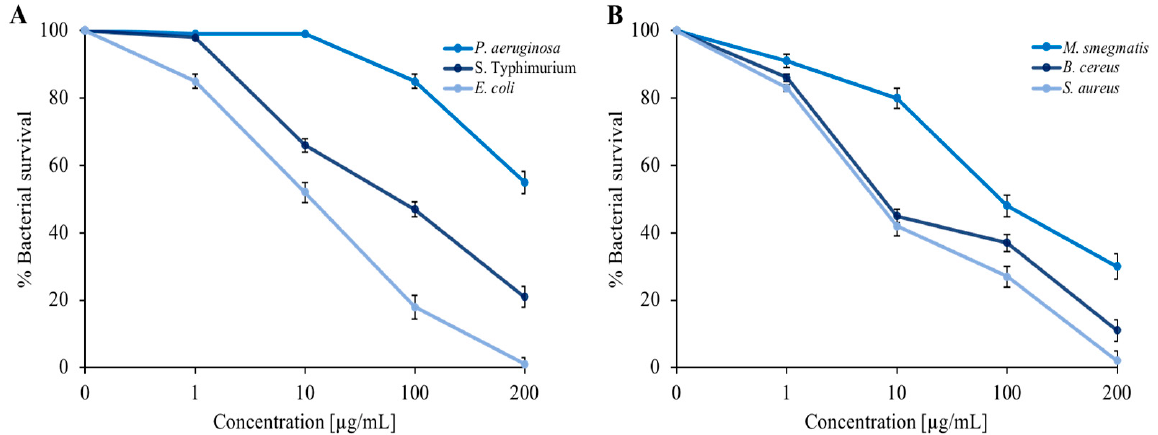
Figure 2. Determination of C. aurantium ‘Crispifolia’ EO antimicrobial activity against ( A ) P. aeruginosa , S. Typhimurium , and E. coli ; and ( B ) S. aureus , M. smegmatis , and B. cereus . The assays were performed in three independent experiments. p value < 0.1.